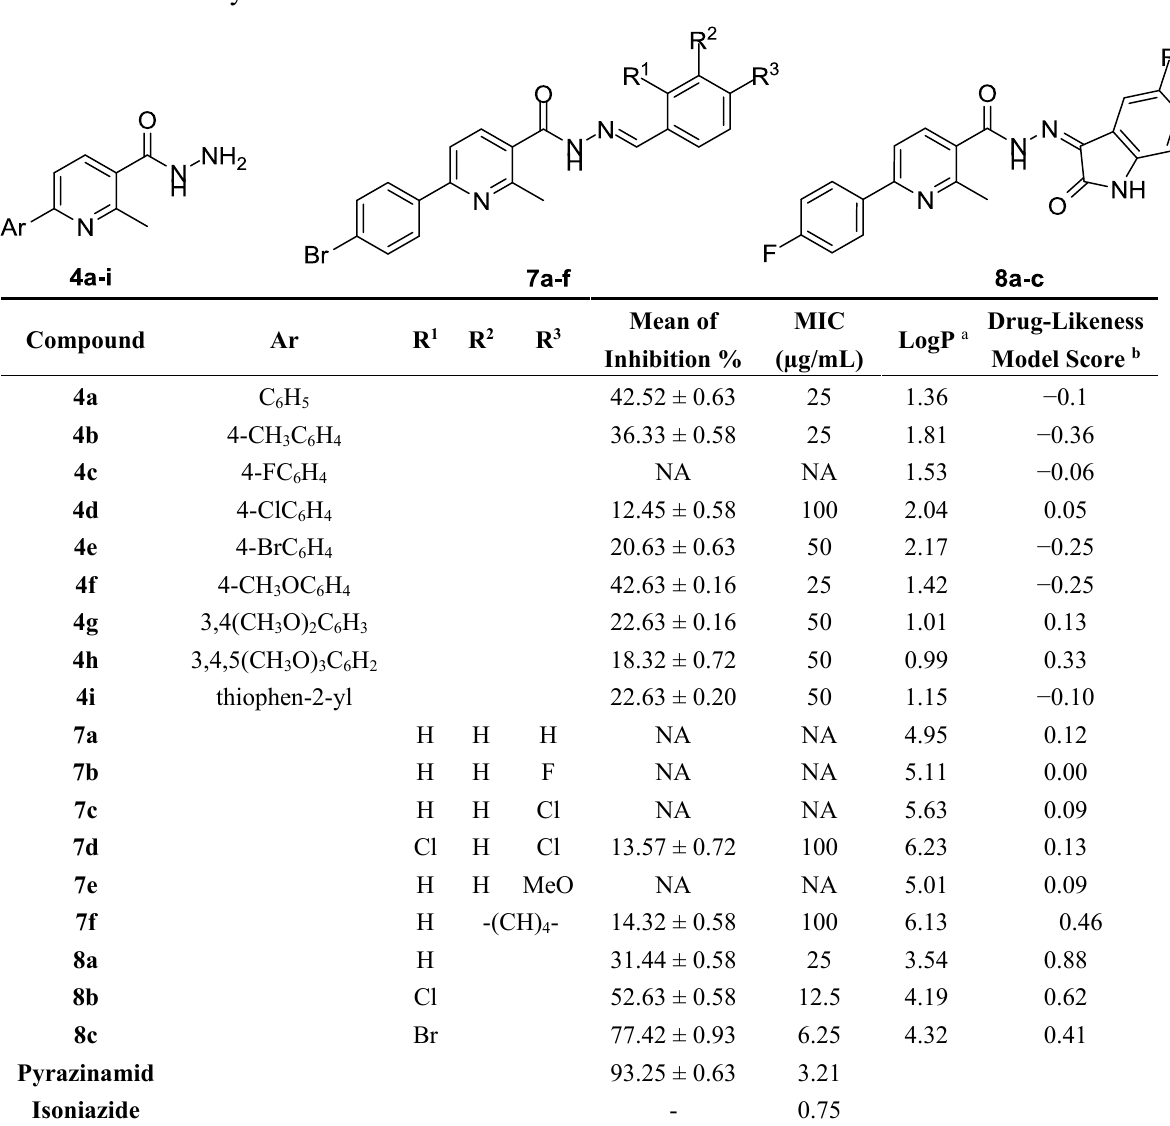
Table 1. Antitubercular activities, LogP measurements and drug-likeness model scores of nicotinic acid hydrazide